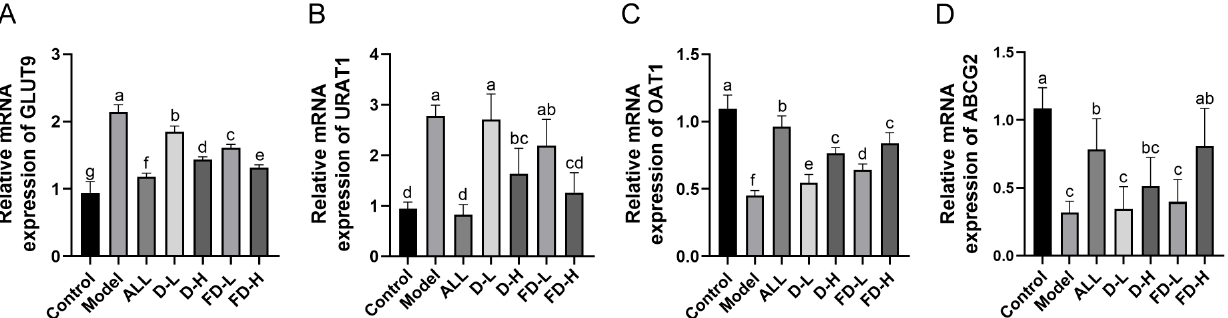
Figure 6. Effects of fermented dandelion on uric acid transporter mRNA in the kidney and small intestine of mice with HUA. ( A ) Renal GLUT9 mRNA level; ( B ) Renal URAT1 mRNA level; ( C ) Renal OAT1 mRNA level; ( D ) Small intestine ABCG2 mRNA level. The data are expressed as mean ± SD (n = 4 or 5). Different lowercase letters indicate statistically significant differences ( p < 0.05) between the groups. ALL, allopurinol; D-L, dandelion low dose group; D-H, dandelion high dose group; FD-L, low dose group of LAFD; FD-H, high dose group of LAFD.